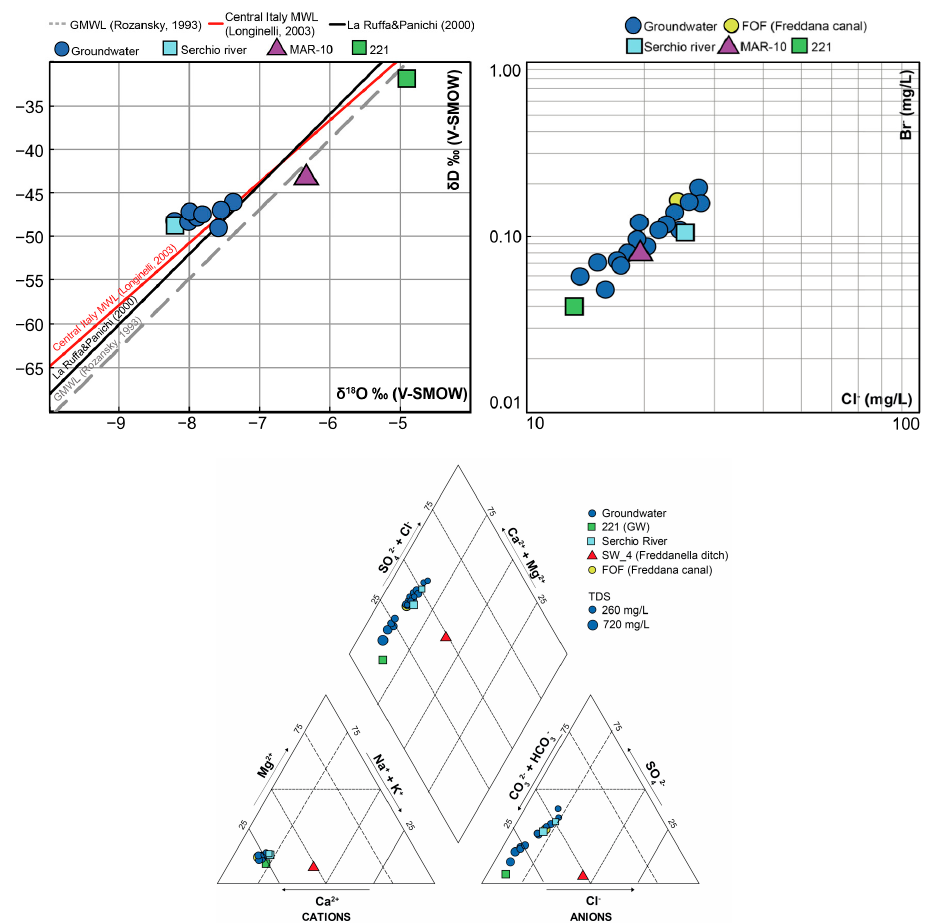
Figure 11. Piper diagram ( bottom ), Cl − vs Br - binary plot ( top right ) and δ 18 O vs δ 2 H binary plot ( top left ) of the samples collected during the dry season of 2015.